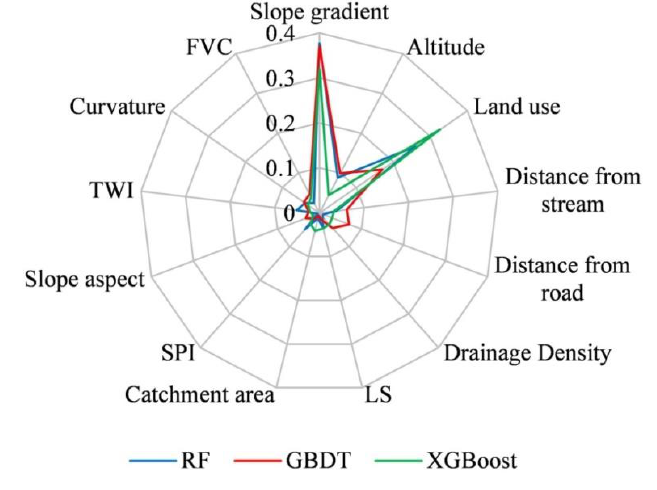
Figure 5. The importance of factors in different models.